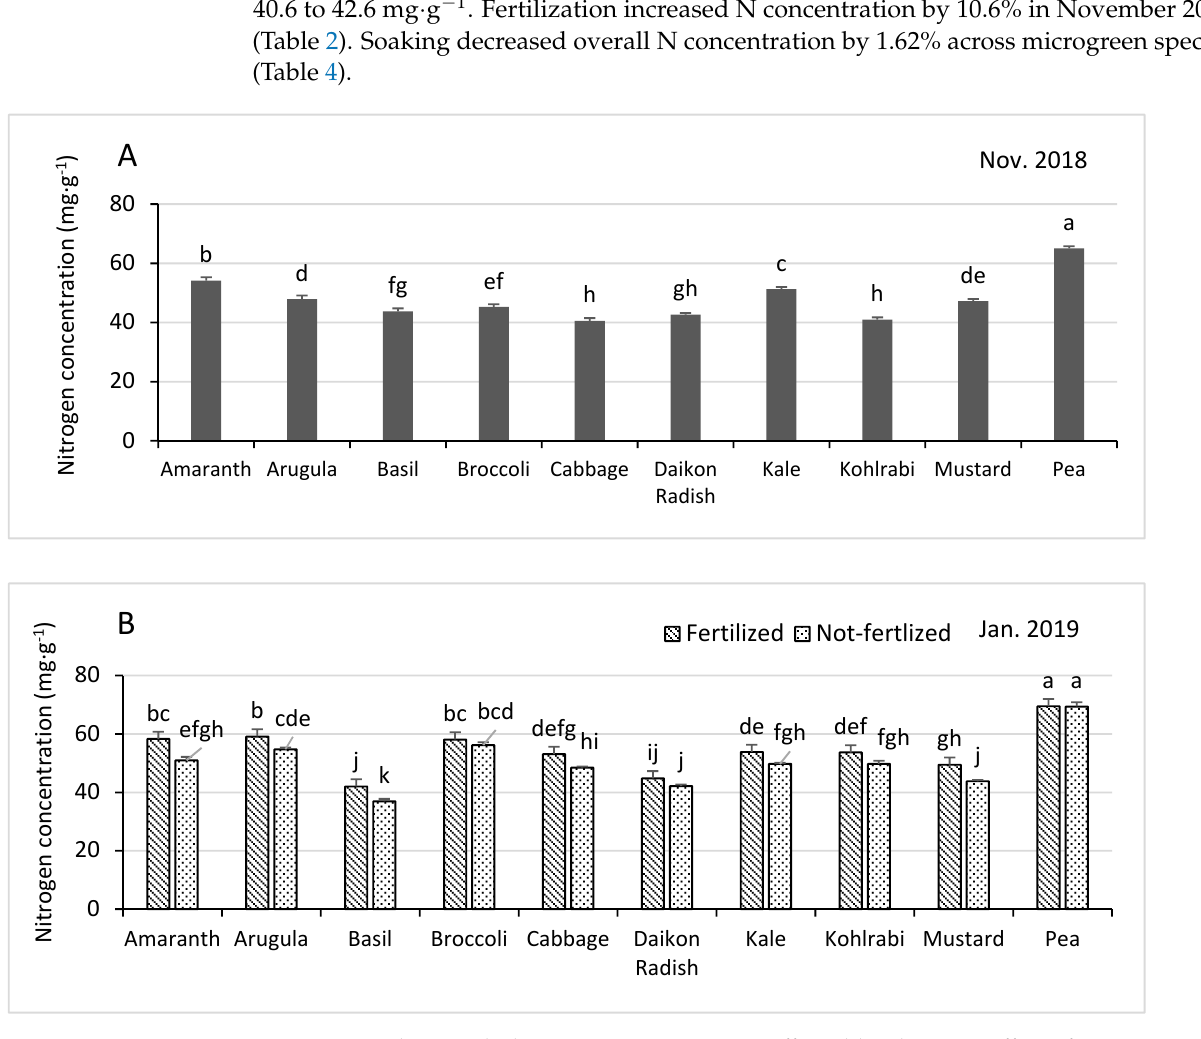
Figure 3. Nitrogen concentrations on a dry weight basis in ten microgreens affected by the main effect of species in November 2018 ( A ) or by the interaction between species and fertilization in January 2019 ( B ). Means with stannard error bars of each species were obtained by averaging data from both fertilization and pre-sowing seed treatments ( A ), or by averaging data from both pre-sowing seed treatments ( B ). Different lowercase letters within a chart suggest significant difference among treatments indicated by Tukey’s HSD test at α ≤ 0.05.